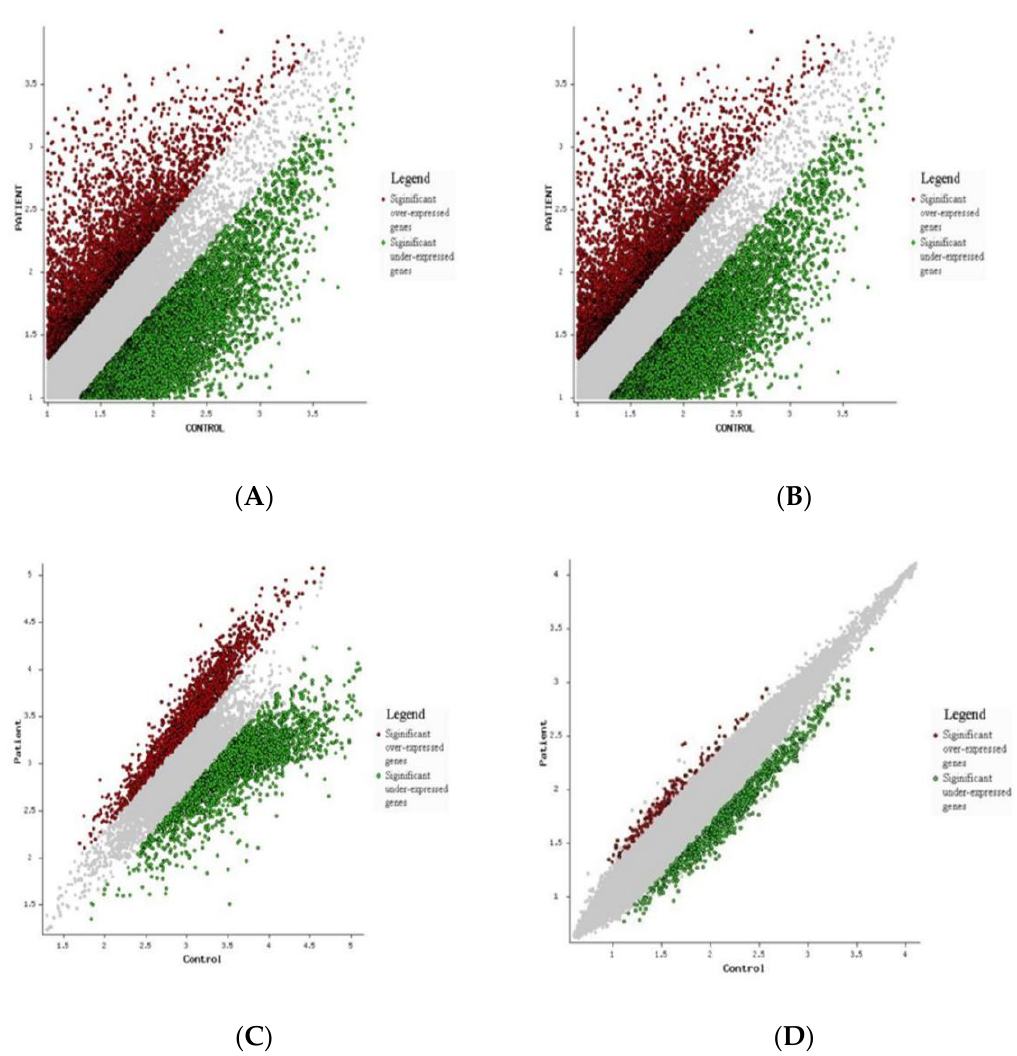
Figure 4. Volcano plots of differentially expressed genes (DEGs) common to teratozoospermia and azoospermia of the four datasets: ( A ) GSE6872, ( B ) GSE6967, ( C ) GSE145467, and ( D ) GSE25518. Significantly over-expressed genes are represented by red dots while significantly under-expressed genes are represented by green dots. Grey dots represent the genes that were not differentially expressed.